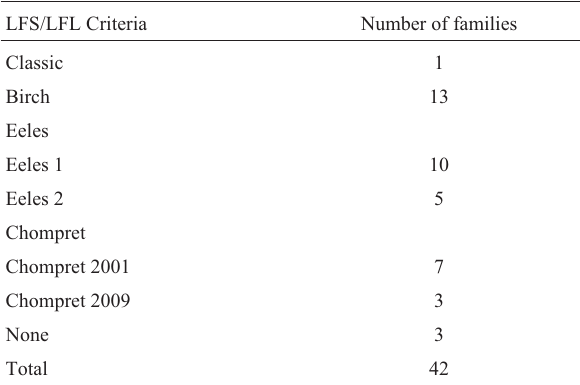
Table 2 - Families carriers of the p.R337H mutation distributed according to different LFS